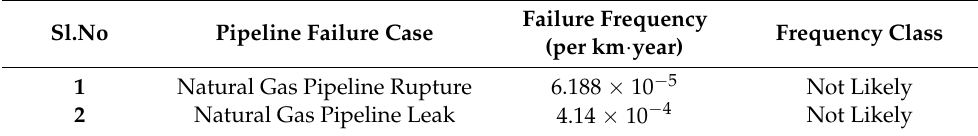
Table 6. Gas pipeline failure frequency and class.